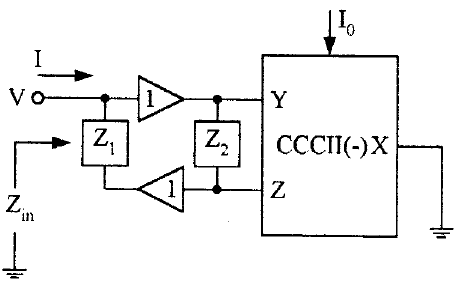
FIGURE 2 A GIC using single CCCII( (cid:1)